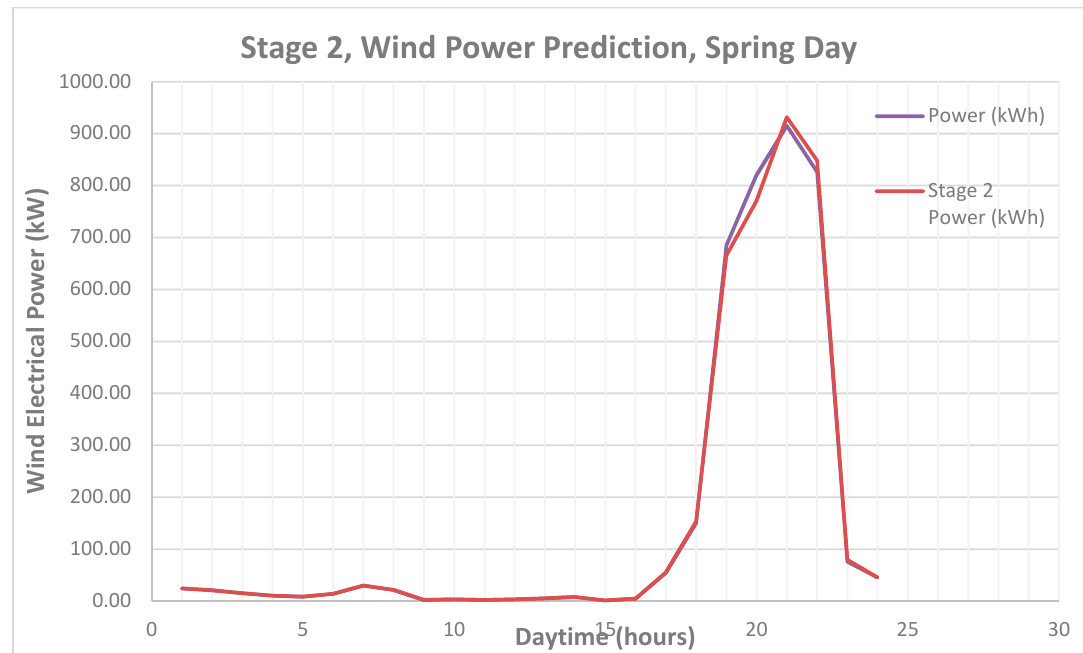
Figure 6. Wind Electrical Power forecasting results from Stage 2, Spring Day.